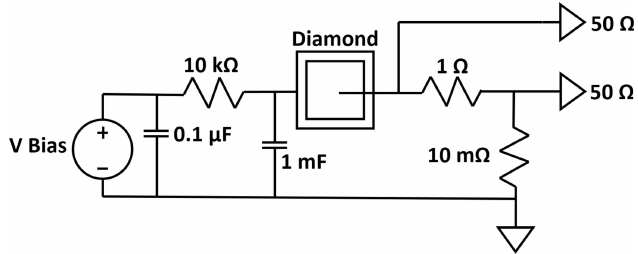
Figure 2 Schematic of the SCIPP assembly readout path; all components except the sensor bias supply are incorporated into the PCB that houses the sensor.